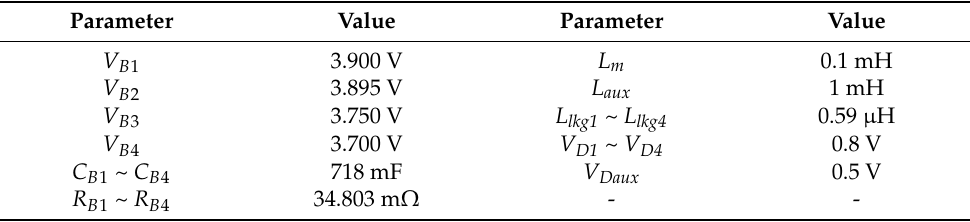
Table 1. Simulation parameters. Parameter